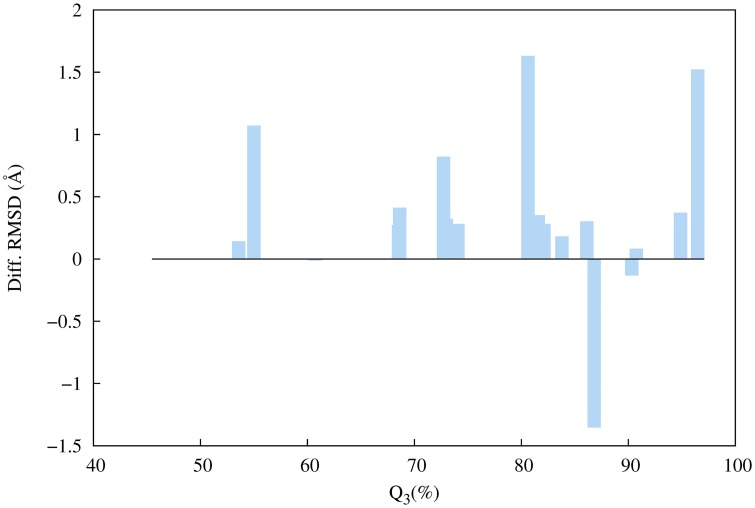
Effect of PSIPRED success rate (%) on the RMSD of the best models.If the difference is greater than zero (DifRMSD > 0) it means the use of PSIPRED is harmful to the prediction. Diff RMSD = Difference between the RMSD of PSI and BLO62 models.